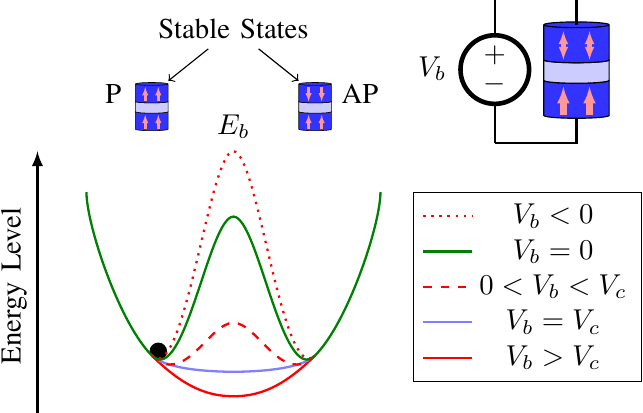
Figure 2. Structure and stable states of the voltage-controlled magnetic anisotropy (VCMA)-MTJ